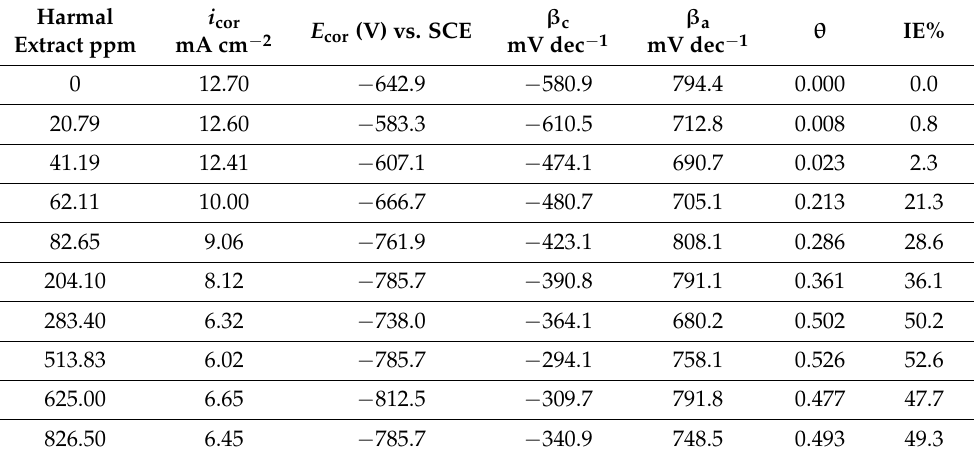
Figure 9. Tafel plots for C-steel in 0.25 M H 2 SO 4 containing different concentrations of Harmal extract (0, 20.79, 41.49, 62.11, 82.65, 204.1, 283.4, 625.0 and 826.5 ppm). Table 4. Polarization parameters for Harmal extract on C-steel in 0.25 M H 2 SO 4